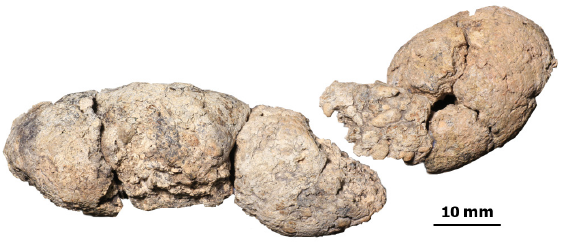
Figure 1. Coprolite (MCP-5176-PV) assigned to Carnivora mammal recovered from the Milton Almeida Outcrop, Touro Passo Formation (Upper Pleistocene), Municipality of Uruguaiana, Western region of State of Rio Grande do Sul, Southern